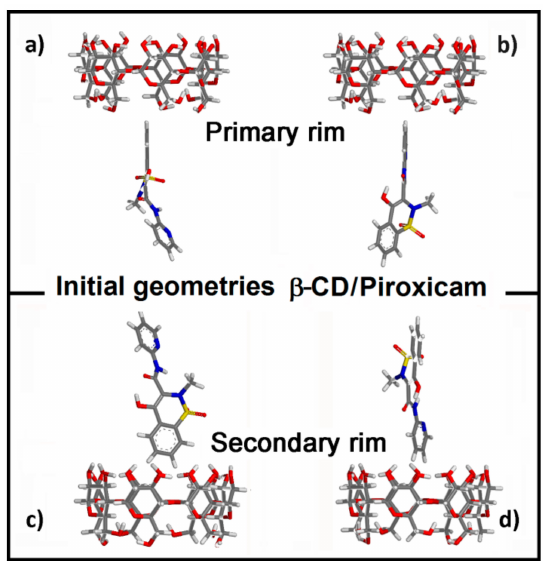
Figure 1. Side view of the four initial non-optimized geometries studied for the interaction between PX and β -CD with the primary rim and with the secondary rim at the top and the bottom, indicated respectively as ( a – d ). The two molecules are colored by atoms. Color codes: C atoms are grey, O atoms are red, N atoms are blue, S atoms are yellow, and H atoms are white.